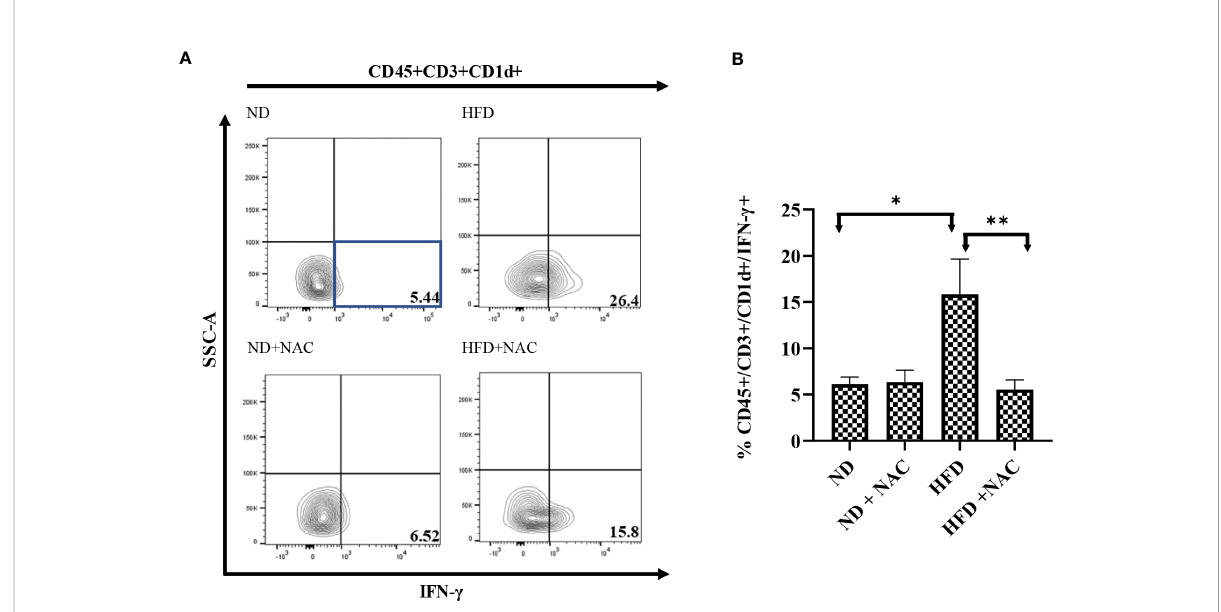
FIGURE 8 IFN- g producing hepatic CD3+/CD1d+ cells are contributors following IRI and successfully ameliorated with NAC supplementation. (A) Representative contour plots of the percentage of IFN- g producing CD45+/CD3+/CD1d+ NKT cells after IRI. Number of mice per group is as follows: ND (IRI)=5, ND + NAC (IRI)=5, HFD (IRI)=7, HFD + NAC (IRI)=10. (B) Histogram demonstrating the percentage of IFN- g producing CD45 +/CD3+/CD1d+ NKT cells illustrated in (A) . “ * ” 0.05 to 0.01, “ ** ” 0.01 to